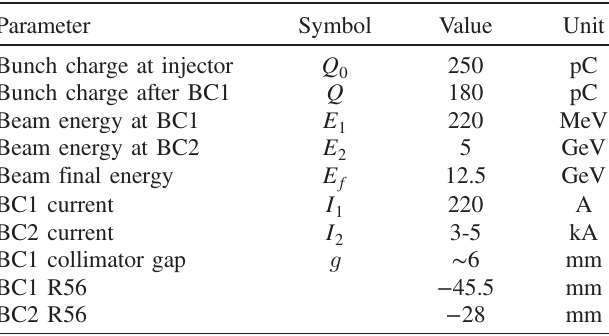
TABLE I. Main machine parameters for Fig. 4 at 7